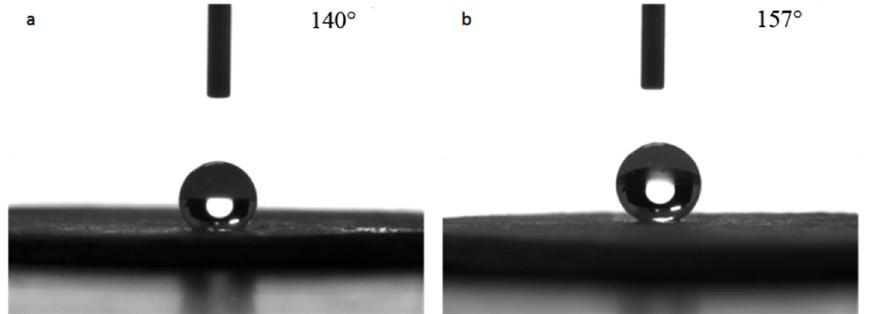
Figure 8. IR spectra analysis of the material treated at different heat treatment temperatures. ( a ) 50 °C; Figure 9. Repairability tests of hydrophobic property of the superhydrophobic bulks. ( a ): pressed ( b ) 100 °C; ( c ) 150 °C; ( d ) 200 °C; ( e ) 250 °C; ( f ) 300 °C. bulk sample; ( b ): after being polished